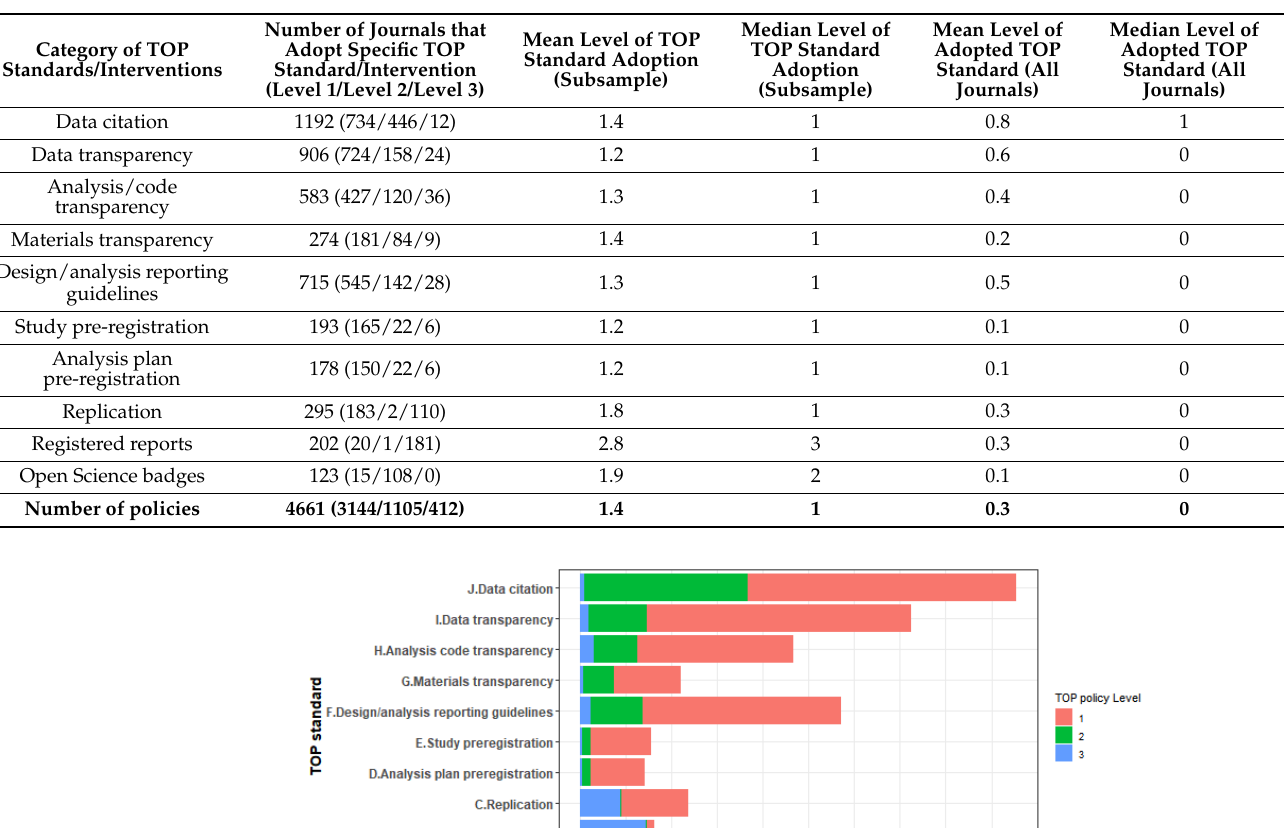
Table 1. Categories of TOP standards and their implementation across journals. Stringency levels were analyzed and reported as the number, mean value and median of journals that adopt a given standard. To obtain statistics for columns 3 and 4, all examples of not implemented TOP standards were filtered out of the analysis. For example, 808 journals that do not implement “Data citation” standards were excluded when mean and median values of the subsample were calculated. To obtain statistics for columns 5 and 6, we calculated the mean and median value across all 2000 journals.